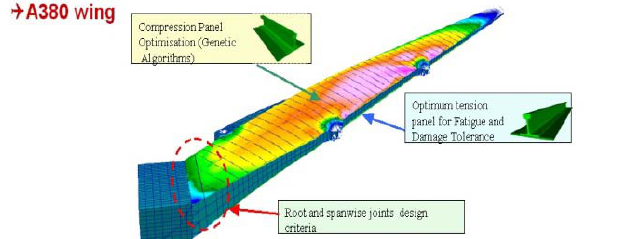
Fig. 2. SOMBRA Optimization of an A380 Wing (The